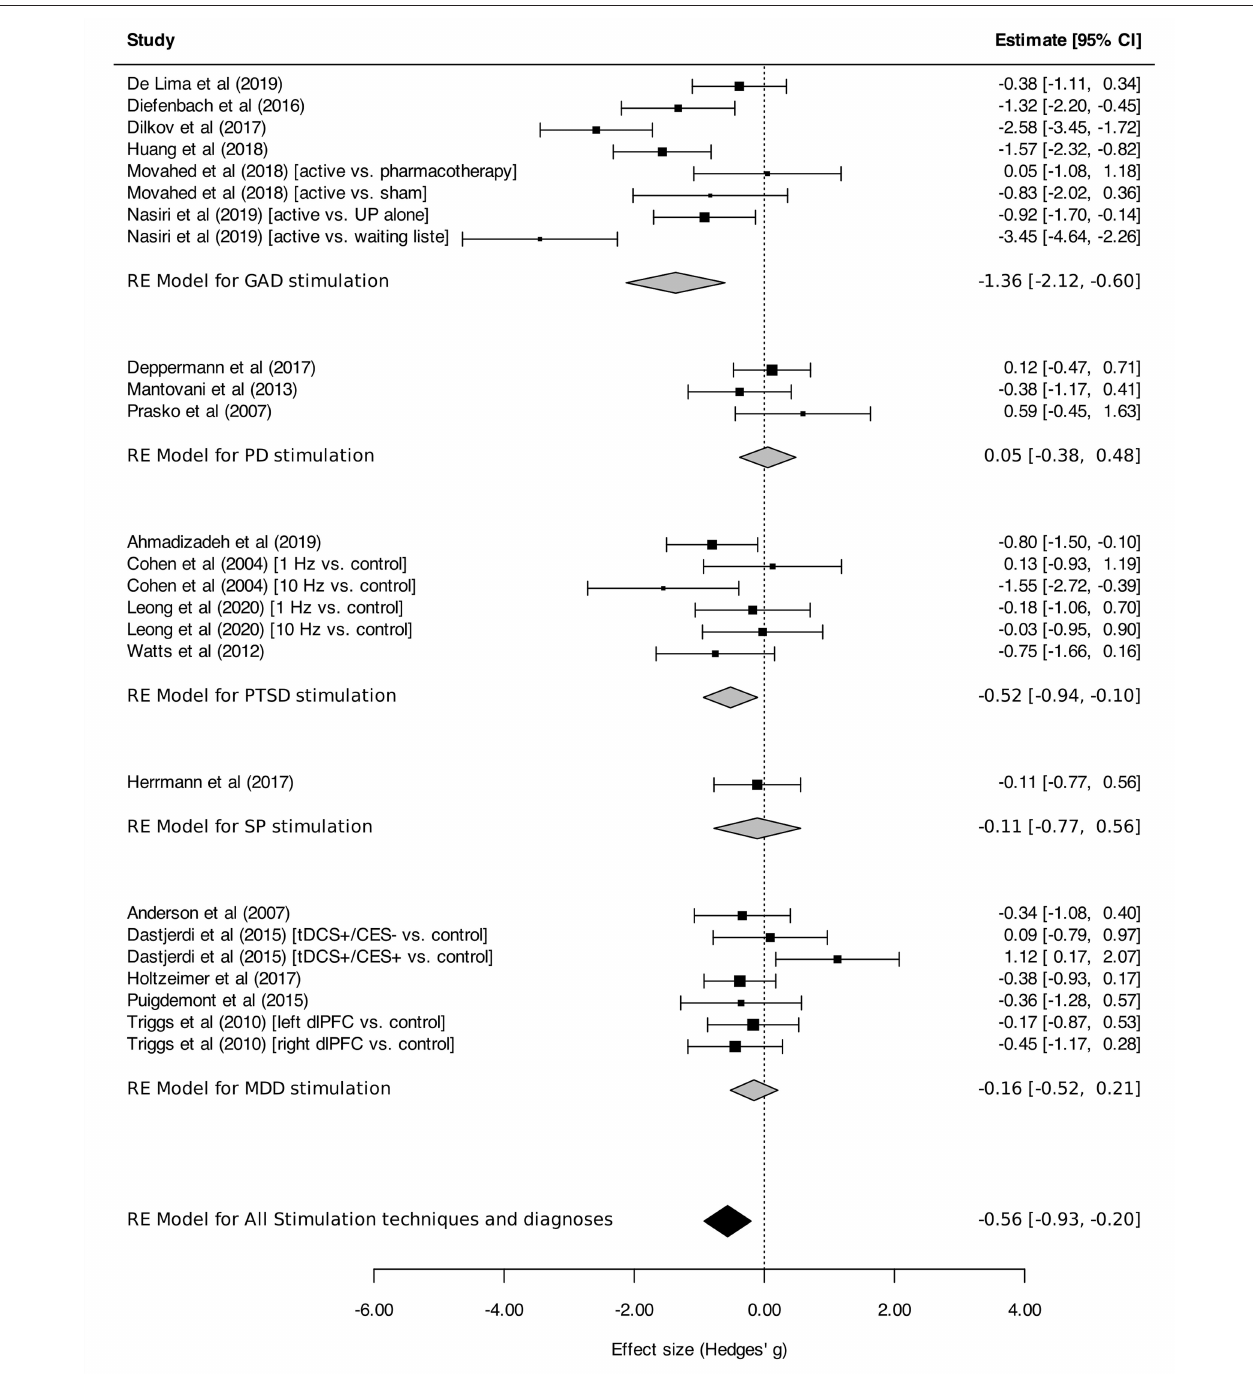
FIGURE 3 | Change in the anxiety symptoms intensity in anxiety, stressor-related disorders and MDD, subgroups by disorder. Statistics: GAD: heterogeneity Sigma1 2 = 0.00, Sigma2 2 = 0.97; Q(df = 7) = 34.64, p < 0.0001); I 2 = 82%; test for overall effect: Z = − 3.52 ( p = 0.0004); PD: heterogeneity Sigma1 2 = 0.00, Sigma2 2 = 0.00; Q(df = 2) = 2.23, p = 0.33); I 2 = 00%; test for overall effect: Z = 0.24 ( p = 0.81); PTSD: heterogeneity Sigma1 2 = 0.00, Sigma2 2 = 0.05; Q(df = 5) = 7.01, p = 0.22); I 2 = 20%; test for overall effect: Z = − 2.44 ( p = 0.22); SP: heterogeneity : not applicable; test for overall effect: Z = − 0.32 ( p = 0.75); MDD: heterogeneity Sigma1 2 = 0.00, Sigma2 2 = 0.05; Q(df = 5) = 7.01, p = 0.22); I 2 = 20%; test for overall effect: Z = − 2.44 ( p = 0.22); Total: heterogeneity Sigma1 2 = 0.06, Sigma2 2 = 0.00; Q(df = 6) = 8.94, p -val = 0.18); I 2 = 30%; test for overall effect: Z = − 3.0599 ( p = 0.002); test for subgroup differences: F(df1 = 4, df2 = 20) = 3.69, p = 0.02.